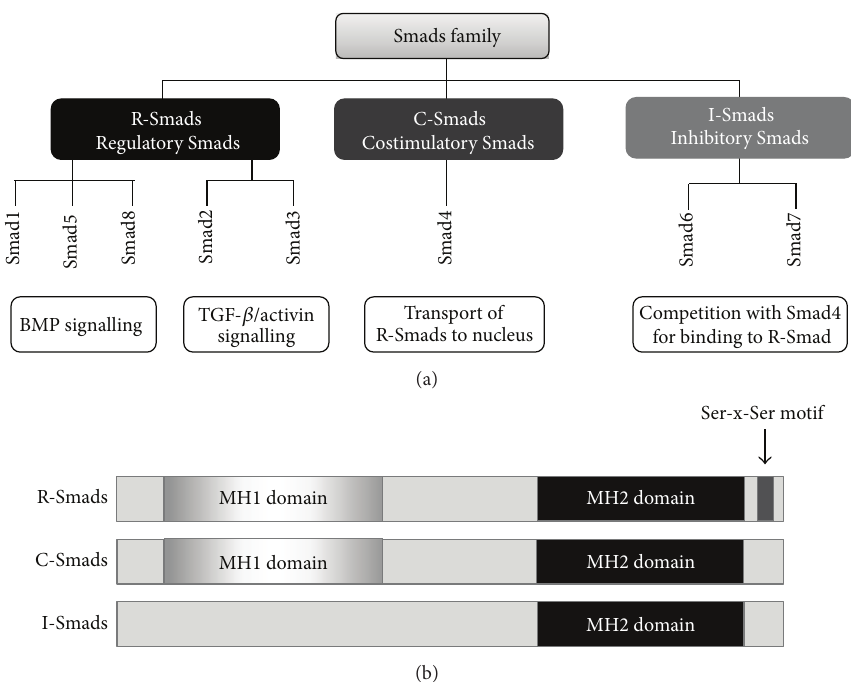
Figure 2: Smad family. (a) The family is composed of three groups: regulatory Smads or receptor-regulated Smads (R-Smads), costimulatory or common-partner Smads (C-Smads), and inhibitory Smads (I-Smads). R-Smads are the ligands for BMP, TGF- 𝛽 , and activin receptors. Co-Smads are responsible for transport of R-Smads to nucleus, whereas I-Smads are negative regulators. (b) The members of each group are characterized by specific domains. R-Smad contains phosphorylation motif, Ser-x-Ser, at the c-terminal region. MH2 domain is present in all members, whereas MH1 domain is not present in